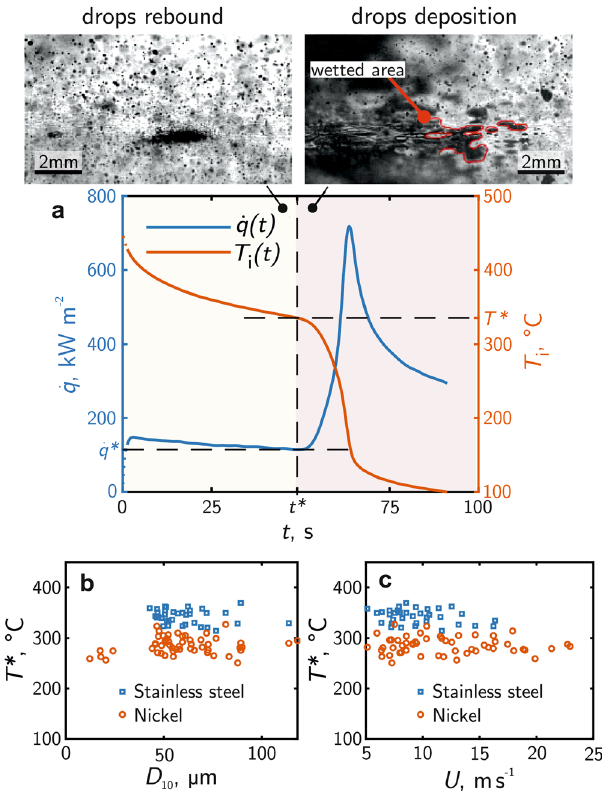
Fig. 3 The threshold temperature T * for spray impact. a Exemplary results for the evolution of the heat fl ux _ q and surface temperature T i as a function of time t for spray cooling with distilled water. The threshold temperature T * at the instant t * corresponds to the minimum heat fl ux. Inserts show liquid patterns on the surface shortly above and below the threshold temperature T * . b and c The dependence of the threshold temperature T * on the average drop diameter D 10 in the spray and on the average impact velocity U , respectively. Each point represents the threshold temperature T * of a spray cooling experiment, as shown in a